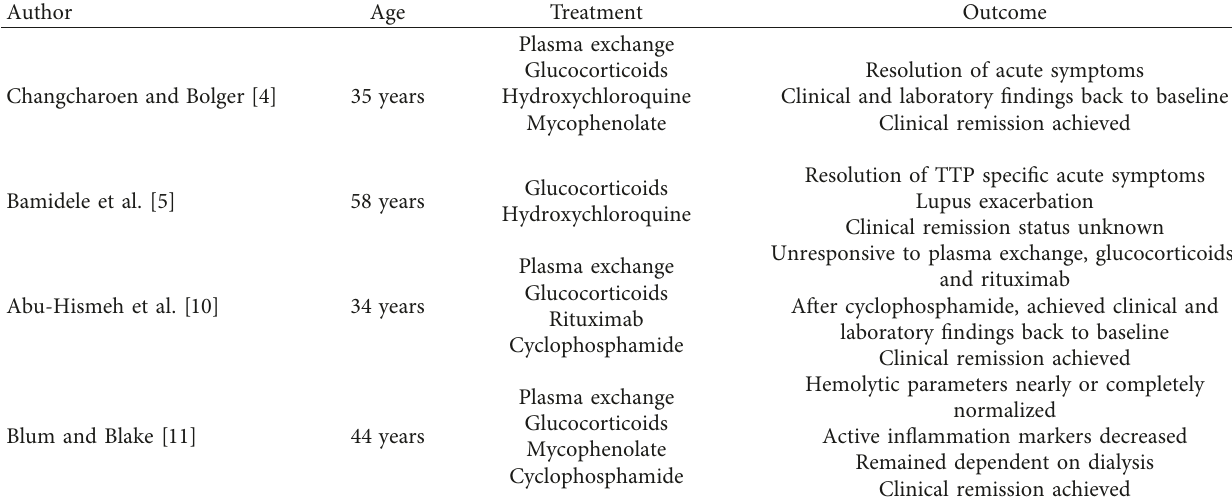
Table 4: TTP and SLE treatments and outcomes.